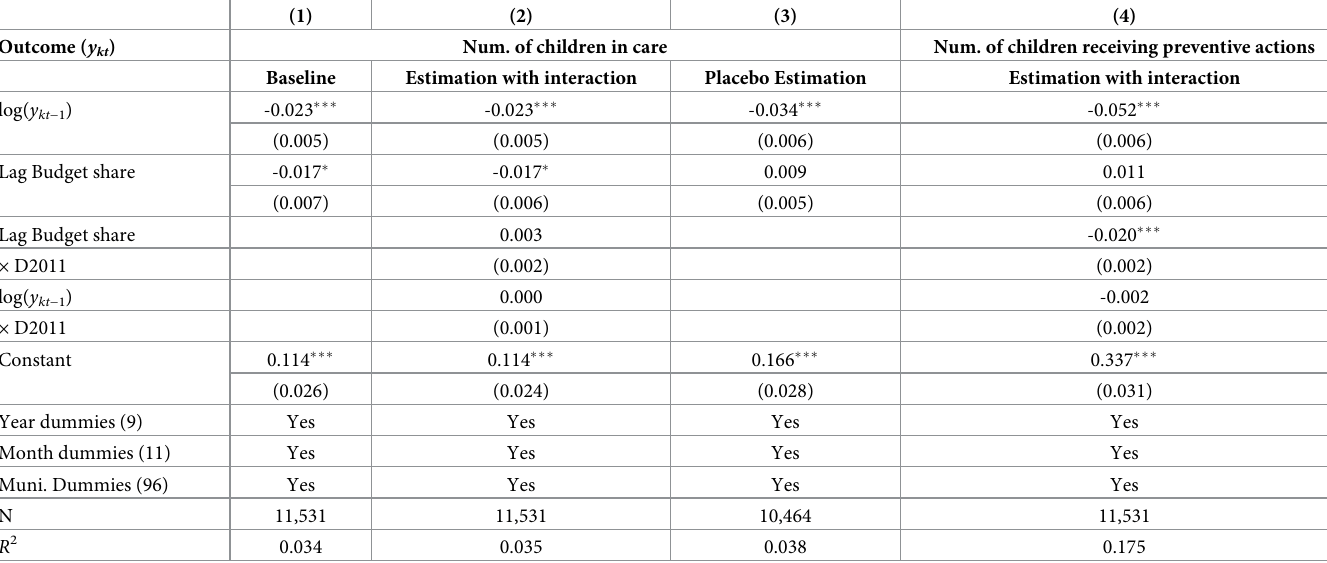
Table 1. Estimation results, municipality-level